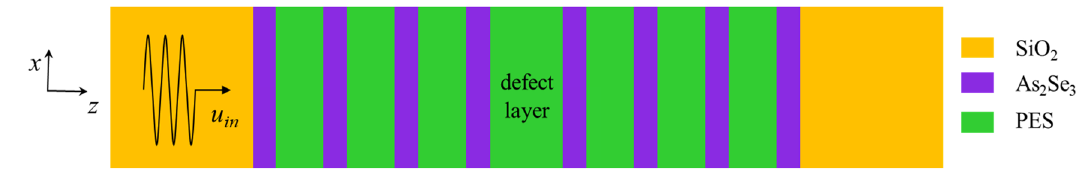
Figure 1: Schematic diagram of 1D multilayer PXC